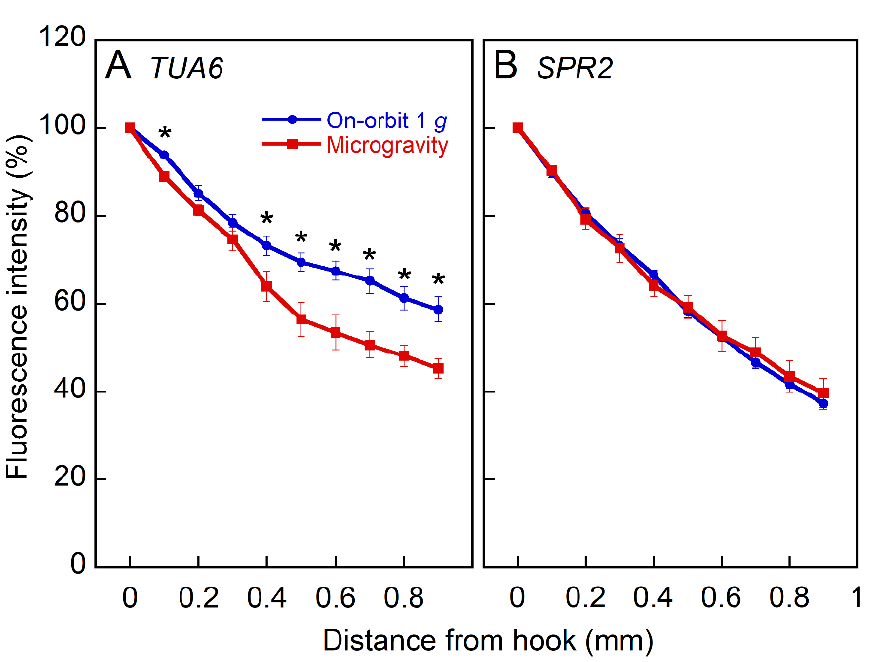
Figure 4. The expression of TUA6 and SPR2 in Columbia hypocotyls. TUA6pro-GFP and SPR2-GFP seedlings were grown at 23.0 °C for 72 h under either on-orbit 1 g or microgravity conditions in the CBEF on the Kibo. The fluorescence image was observed with the CB microscope, and fluorescence intensity of each 100 μm region was determined using ImageJ software. The expression level was normalized to the intensity value of the tip. *, Mean values with significant differences between the on-orbit control and microgravity ( n = 10, p < 0.05).